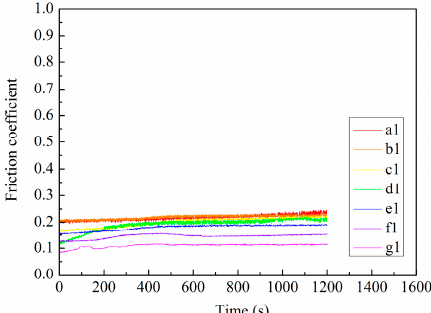
Figure 15. Friction coefficient of the microarc oxidation self-lubricating composite coatings formed on aluminum alloys at different anode pulse-widths. (a1): 1000 μ s; (b1): 1500 μ s; (c1): 2000 μ s; (d1): 2500 μ s; (e1): 3000 μ s; (f1): 3500 μ s; (g1): 4000 μ s.